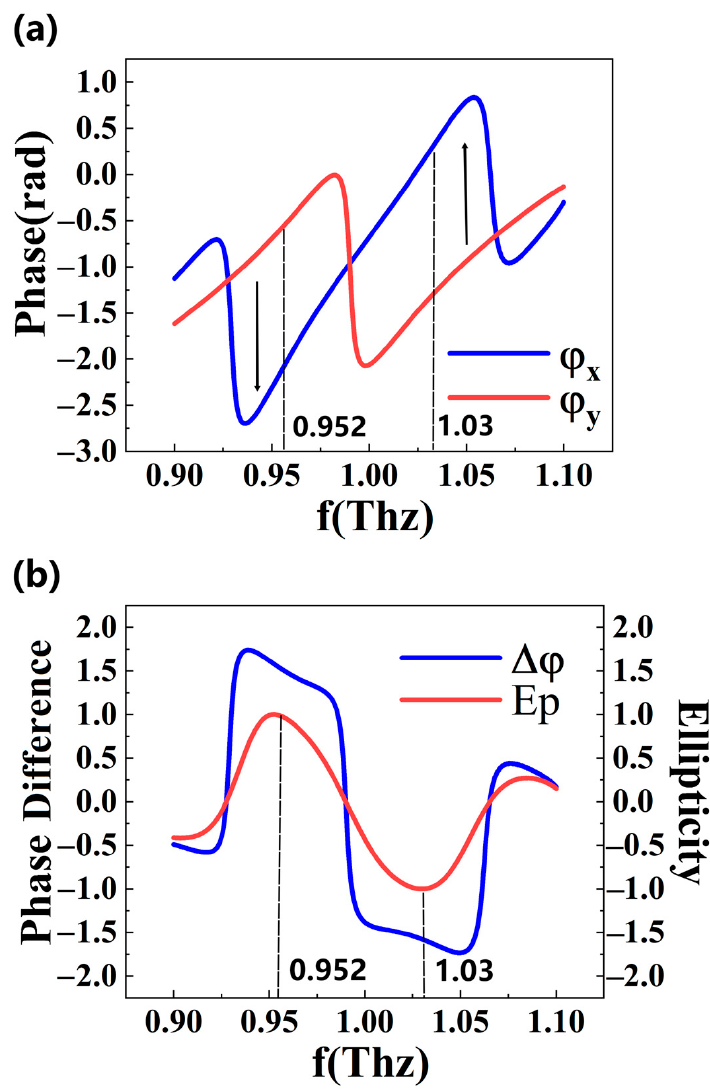
Figure 3. ( a ) Correspondence of the phase delay of the x and y electric field components with frequency. ( b ) Correspondence of frequency with phase difference and ellipticity.